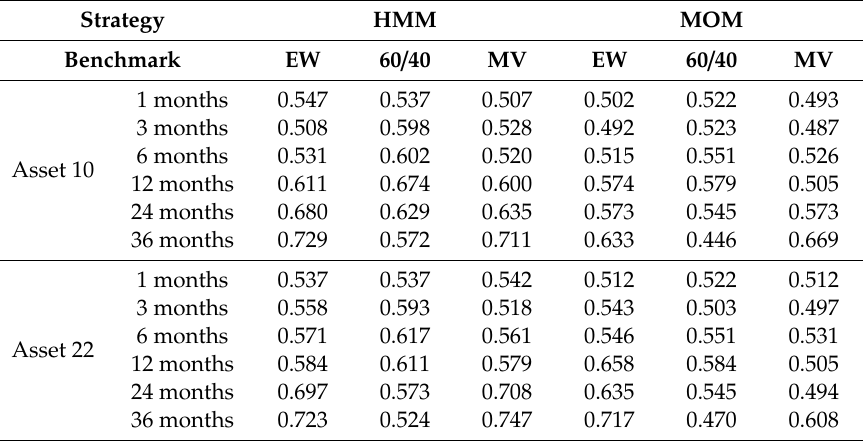
Table 5. Portfolio Outperformance Probability.